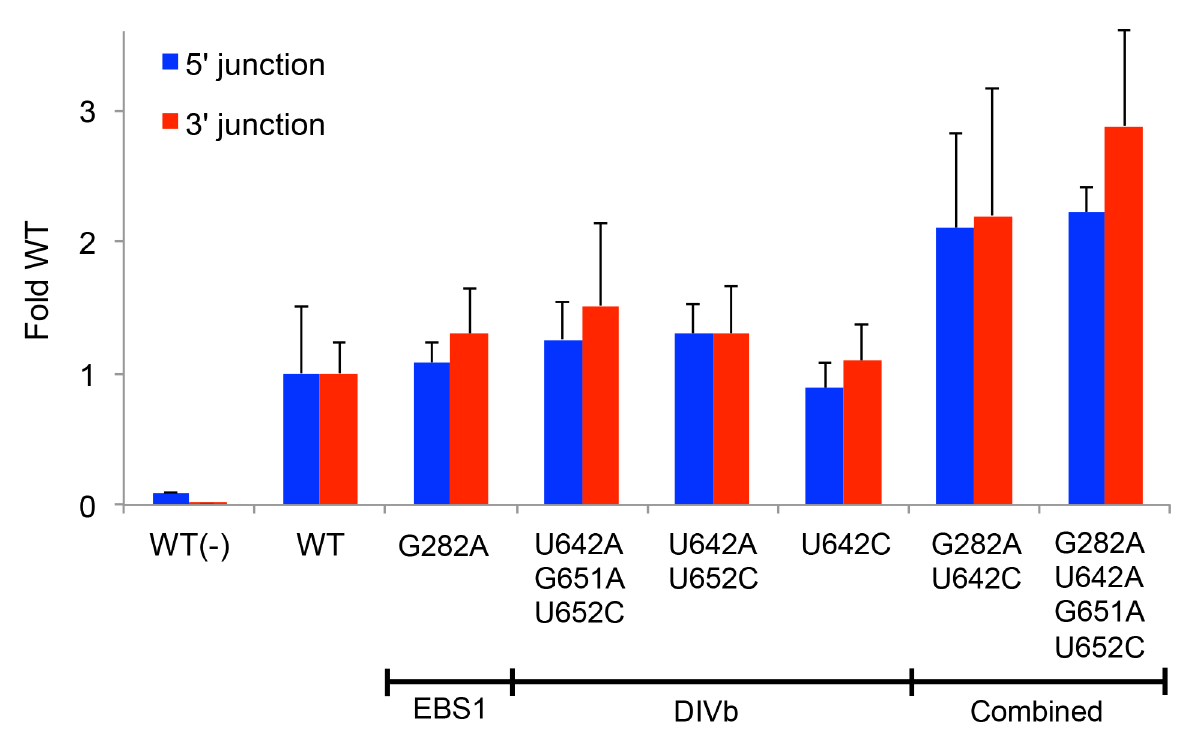
Fig 8. Retrohoming frequencies of Ll.LtrB variants containing positively selected mutations identified by PacBio sequencing. The prominent mutations in EBS1 (G282A) and DIVb (position 642) were combined with other positively selected mutations that showed covariation and tested for retrohoming into a plasmid target site in HEK-293 cells in culture medium supplemented with 80 mM MgCl 2 . Retrohoming frequencies were measured at 24 h after transfection of the expression plasmids in adherent HEK-293 cells by Taqman qPCR assays of the 5 ’ - and 3 ’ -integration junctions relative to the hyg R marker adjacent to the target site. The bar graphs show retrohoming frequencies of the variants relative to that of the wild-type intron. Values with error bars are the mean ± SD for at least three experimental trials. Values without error bars were tested once. The negative control WT(-) is the wild-type intron tested without additional MgCl 2 in the culture medium. Retrohoming frequencies for the wild-type intron measured by Taqman qPCR of 3 ’ -integration junctions ranged from 0.06 – 0.11% in this series of experiments.